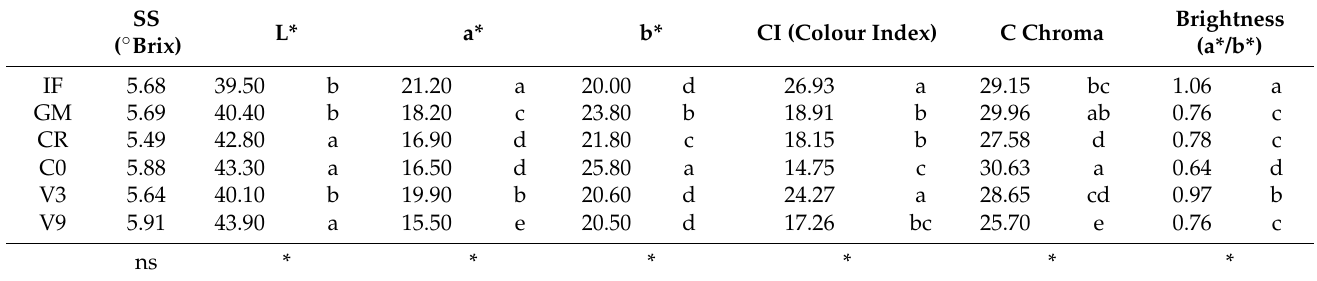
Table 4. Effect on soluble solids (SS) content ( ◦ Brix), and fruit colours (L*, a*, b*, CI, C, a*/b*) in tomato crop fertilised with inorganic fertilisers (IF), goat manure at 3 kg m-1 (GM), crop residue at